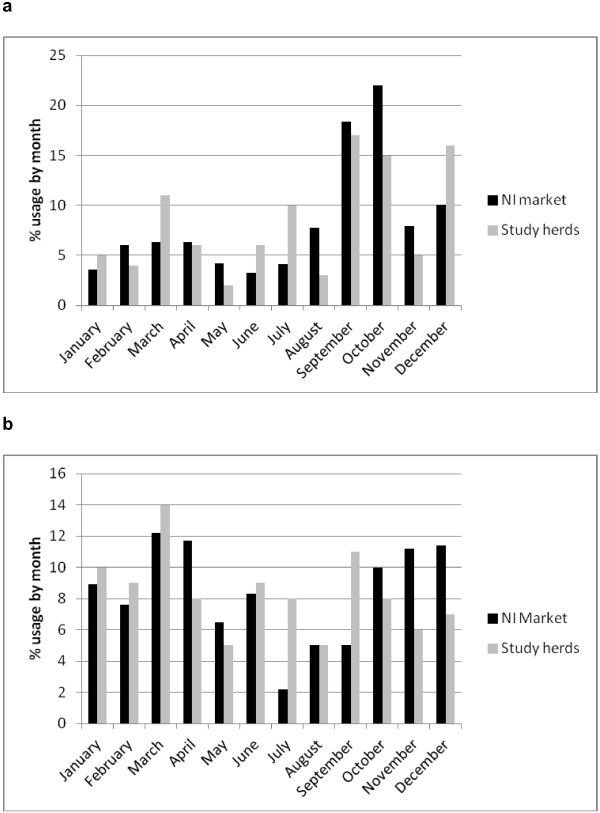
Monthly vaccine usage on 501 Northern Irish farms and regionally during 2010. a. shows BoHV-1 vaccine; b. shows BVD vaccine.